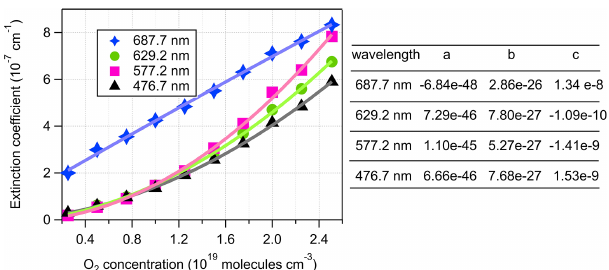
Figure 4. Second-order polynomial fit of extinction coefficients measured by the BBCES system. The O 2 concentration-dependent extinction coefficients are contributed by the extinction coeffi- cients of O 2 ( σ O ), He ( σ He ), and the O 2 –O 2 CIA cross sections 2 ( σ O 2 − O 2